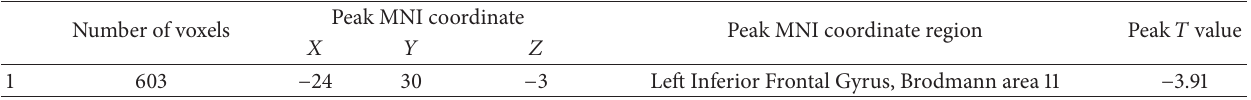
Table 2: CBF difference between two groups and their location.